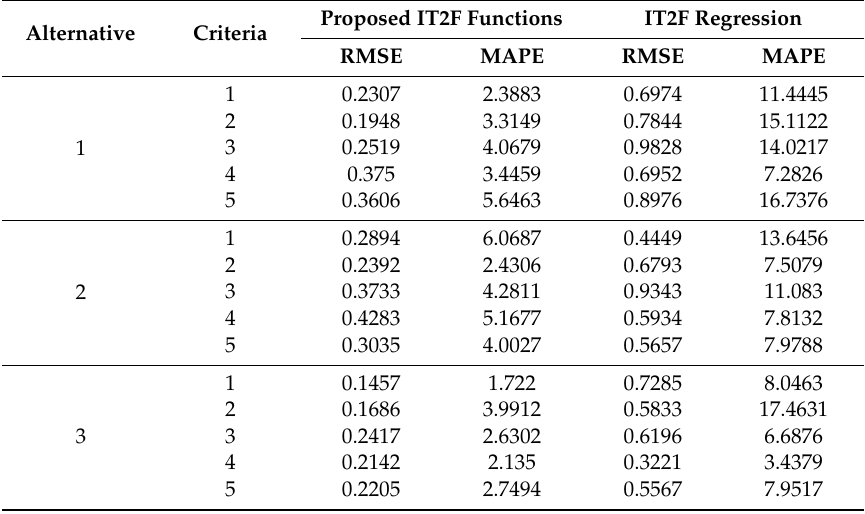
Table 6. Performance comparison of the proposed method and IT2F regression.